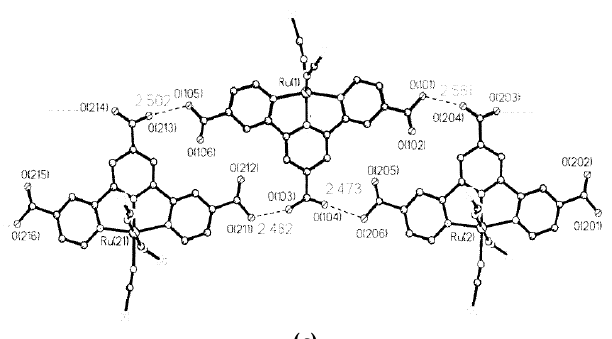
Figure 2. ( a ) Black Dye (BD) or N749 structure; ( b ) light absorption spectrum (red) and IPCE (black) [12] (Adapted from Ref 12 with permission of The Royal Society of Chemistry); and ( c ) crystal structure showing intermolecular hydrogen bonding [21] (Reprinted with permission from Nazeeruddin, M. K.;